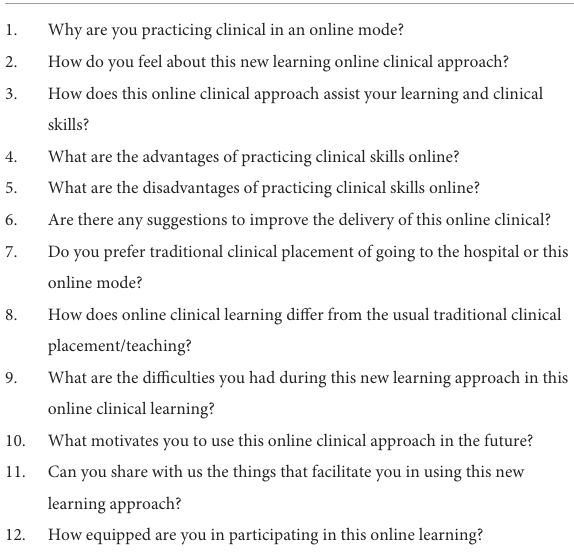
TABLE 3 Guided questions for the focus group